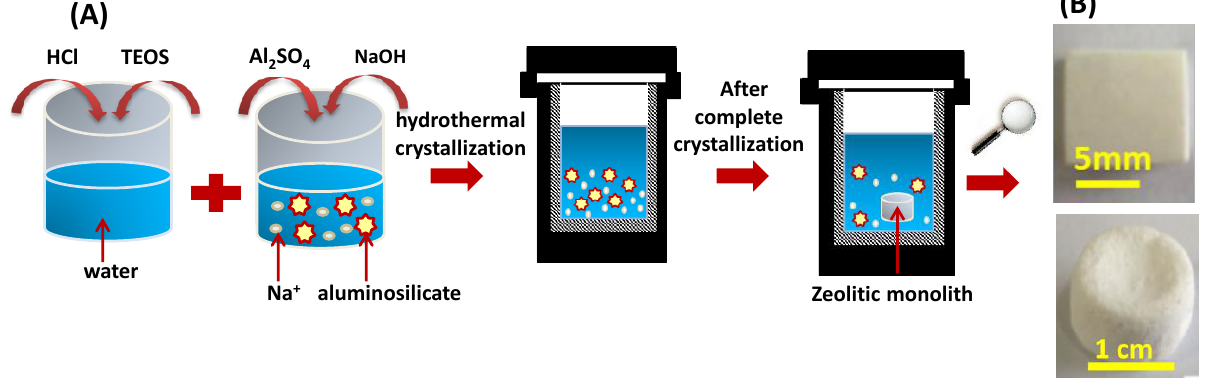
Figure 7. ( A ): Schematic illustration of one-step template- and binder-free synthesis rout for preparing mordenite monoliths, ( B ): obtained monoliths with different shape geometries.[95].